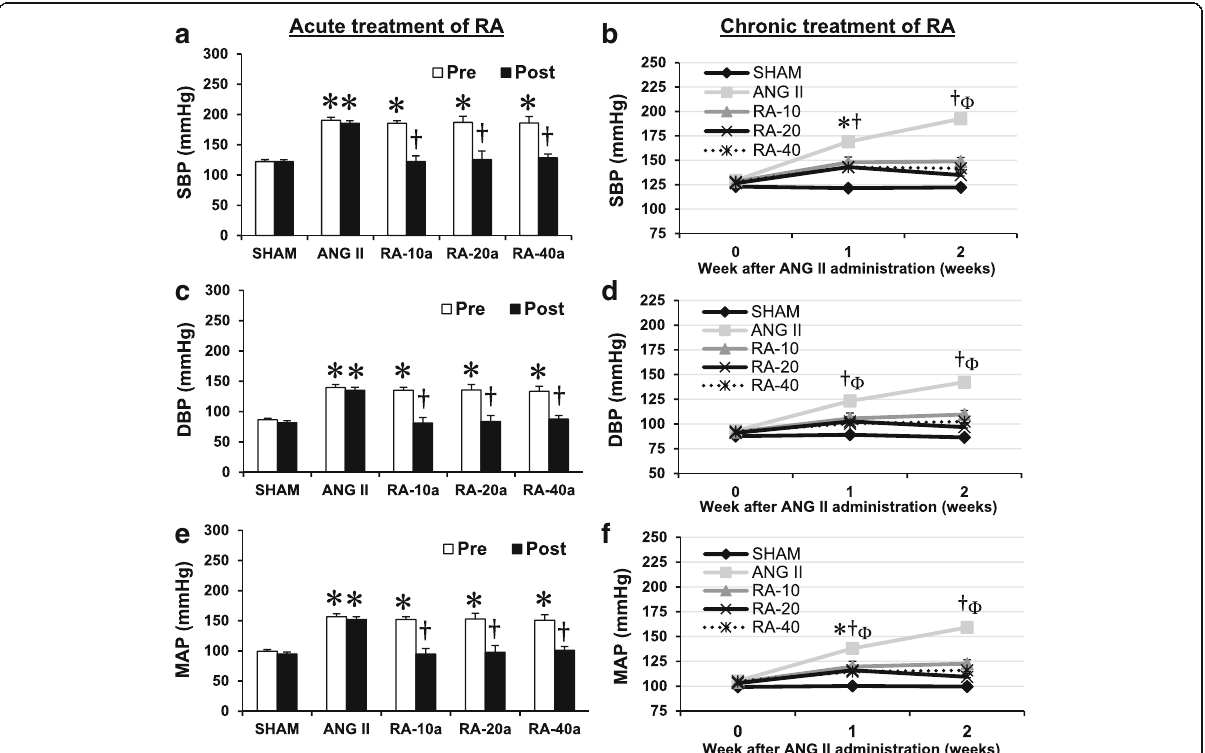
Fig. 1 Systolic blood pressure (SBP), diastolic blood pressure (DBP), and mean arterial blood pressure (MAP) in SHAM, ANG II, acute RA treatment (RA-10a, -20a, and -40a mg/kg) ( a , c , e ), and chronic RA treatment (RA-10c, -20c, and -40c mg/kg) ( b , d , f ) groups. Values are the mean ± SE. * P < 0.05 vs SHAM group; † P < 0.05 vs ANG II group; Φ P < 0.05, R-10c vs SHAM group